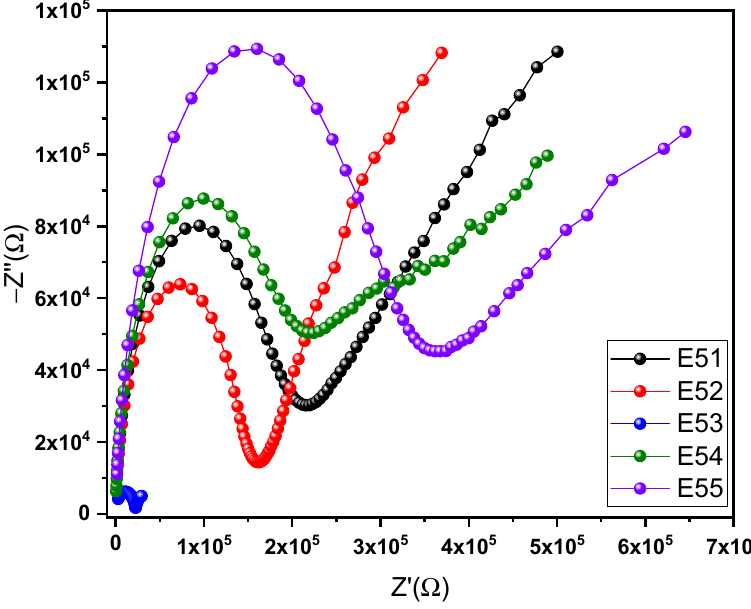
Figure 6. Obtained Nyquist plots for the nano-ZnO-incorporated coatings after 7 days of exposure. Electrochemical impedance spectroscopy of the coated steel specimens obtained dur- ing exposure to the aerated 3.5 wt.% NaCl aqueous solution was performed for the se- lected exposure times of 1 h and 7 days. The Nyquist plots showed two time constant semicircles for all the coatings containing nanoparticles after exposure of 1 h except the E52 sample, where a single semicircle was obtained. The semicircle is an indication of a compact coating. After the exposure of 7 days in the chloride solution, a second time con- stant was obtained, which was detected as a second semicircle in the Nyquist plots of all the coating samples. This means that the corrosive electrolyte penetrated into the coating interface in a very short immersion time [39]. In order to obtain the correct information regarding the coating performance when exposed to the electrolyte solution, the obtained Nyquist data were fit using the electrochemical model shown in Figure 7, where R is the solution resistance, R P1 is the coating resistance (assuming coatings contain pores), Q 1 is a constant phase element, R P2 is the charge transfer resistance, Q 2 is a second constant phase element. The values obtained for these parameters are reported in Table 5. The R P1 corre- sponds to the resistance between the epoxy coating surface and the electrolyte solution, which was assumed to be of a porous nature. In the following circuit, both R P1 and R P2 are connected in series; hence, the polarization resistance is equivalent to the sum of both resistances [40–42]. Figure 7. Equivalent circuit model used to fit the EIS data.